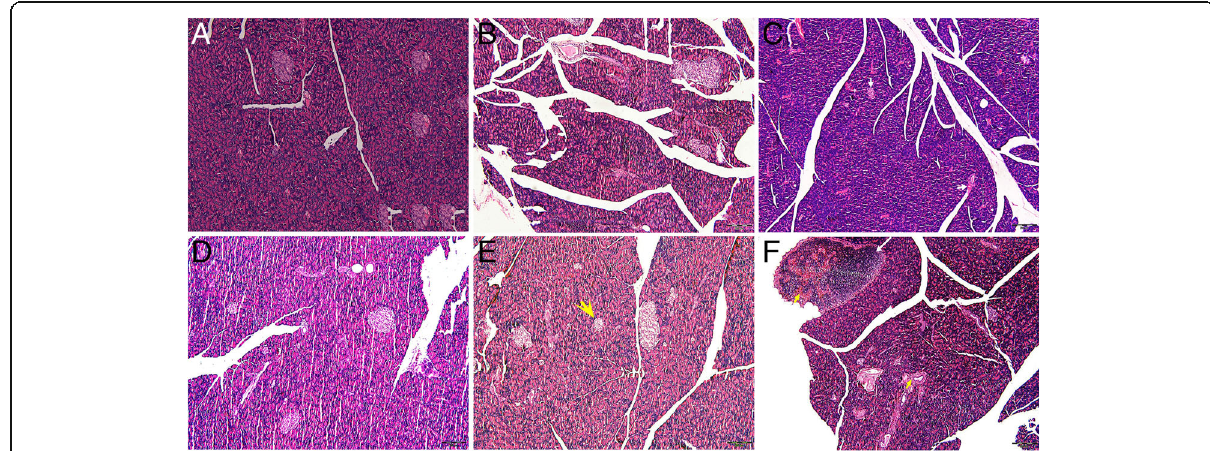
Fig. 3 Histological analysis of pancreatic tissue stained with hematoxylin and eosin. Upper panel ( a – c ) and lower panel ( d – f ) show female and male pancreas histological structure, respectively. a A representative micrograph of the pancreas of control females rat showing normal structure, normal beta cells shape and distribution. b Pancreatic micrograph section of rats fed 50% GM food showing normal histology with some atrophied beta cells. c A micrograph of rats fed 100% GM showing atrophied beta cells, hemolysis in different areas of the pancreas and amyloid bodies (white arrows). d A representative micrograph of the pancreas of control male group rat showing normal structure. e A section in the pancreas of group fed 50% GM food showing normal histology and some atrophied beta cells (yellow arrow). f Pancreatic section of group fed 100% GM showing amyloidosis (yellow star), neutrophil infiltration (long white arrow), and non-malignant pancreatic fibrosis (yellow arrows). It seems like an acute pancreatitis, which is associated by hypokalemia as reported by biochemical tests. Scale bar is 200 μ m